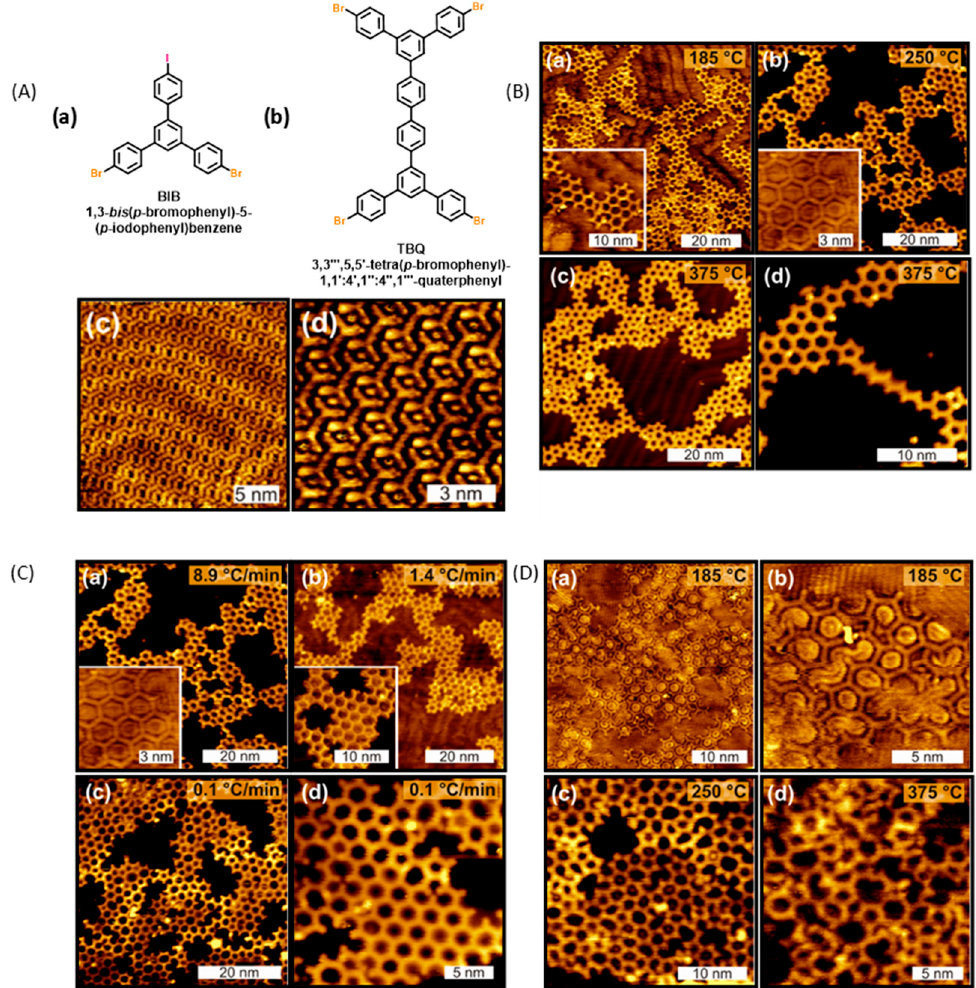
Figure 7. ( Aa , b ) Chemical structures of 1,3- bis ( p -bromophenyl)-5-( p -iodophenyl)benzene (BIB) and TBQ. ( Ac , d ) STM images of supramolecular self-assembly of 3,3 (cid:48)(cid:48)(cid:48) ,5,5 (cid:48) -tetra( p -bromophenyl)- 1,1 (cid:48) :4 (cid:48) ,1 (cid:48)(cid:48) :4 (cid:48)(cid:48) ,1 (cid:48)(cid:48)(cid:48) -quaterphenyl (TBQ) on Au(111) surface. ( B ) STM images of the 2D polymers